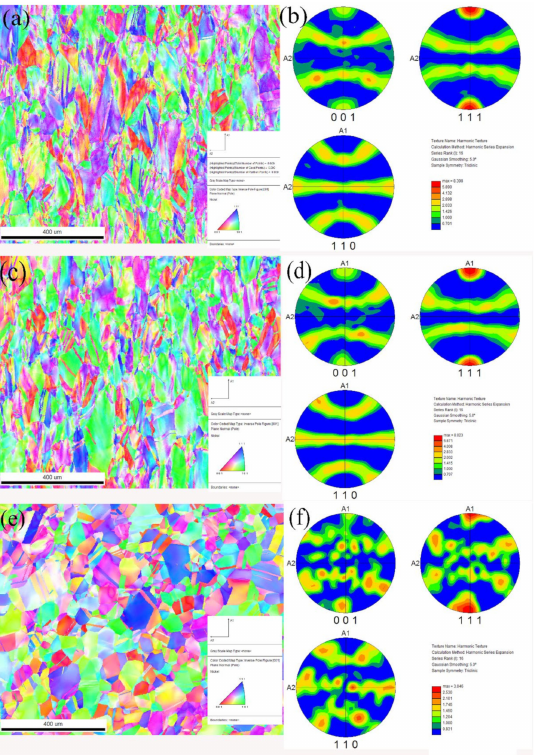
Figure 3. IPF and PF of samples obtained by stretching at different temperatures: ( a ) IPF, room temperature, ( b ) PF, room temperature, ( c ) IPF, 400 ◦ C, ( d ) PF, 400 ◦ C, ( e ) IPF, 600 ◦ C, and ( f ) PF, 600 ◦